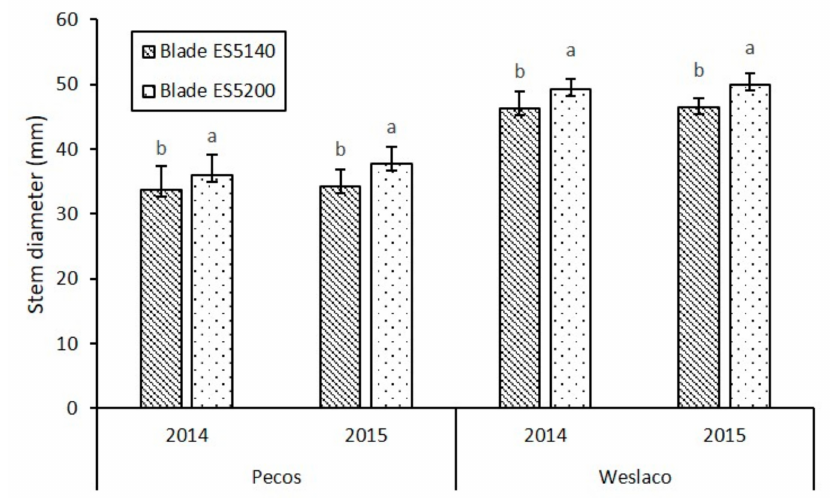
Figure 4. Stem diameter of the two energy sorghum cultivars at harvest in the two growing seasons.